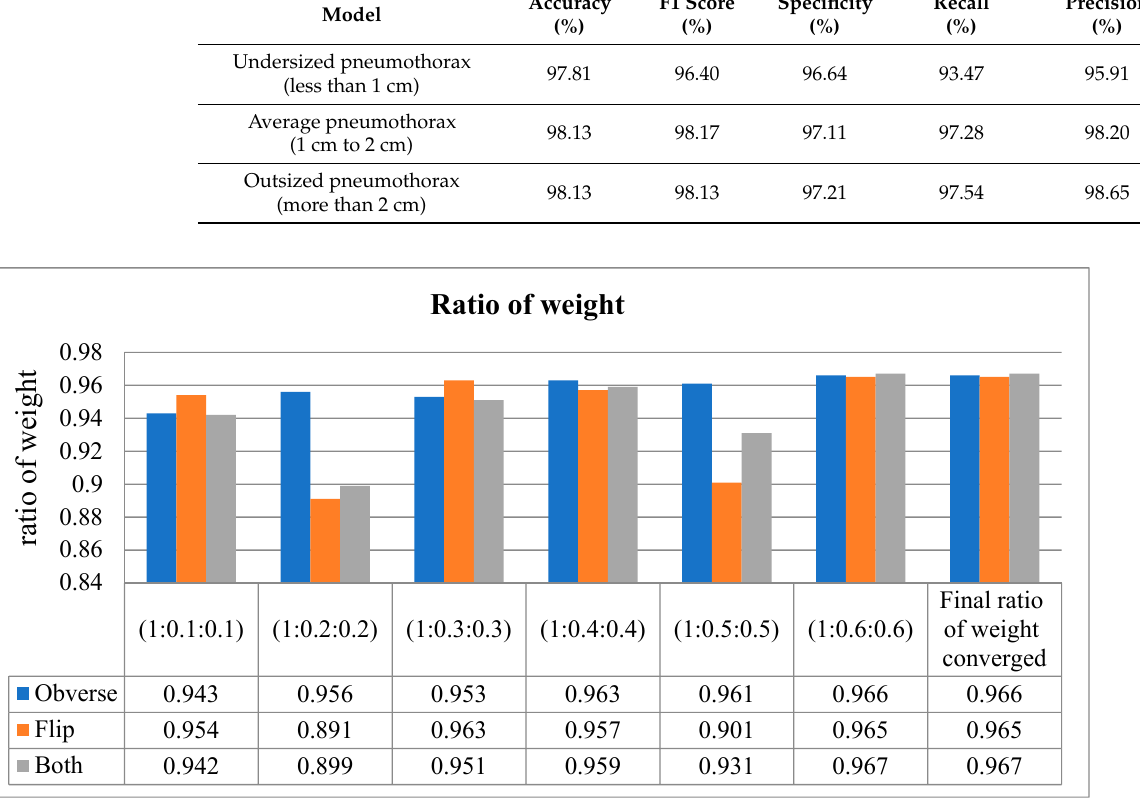
Figure 8. Grad-Cam heat map of the proposed model(cid:31)s output.